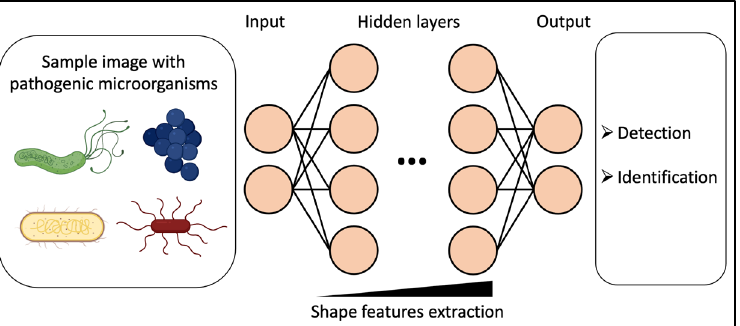
Figure 7. Diagram of deep learning applied to the detection and identification of microorganisms in microscopic images.